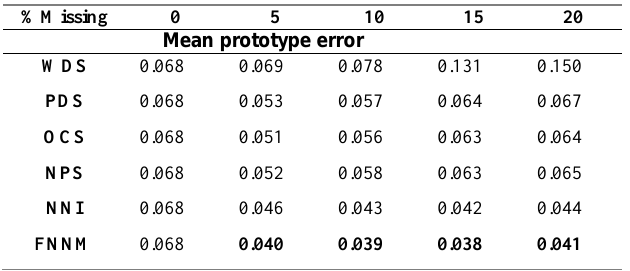
‎ Table 5. Mean prototype error on Iris.